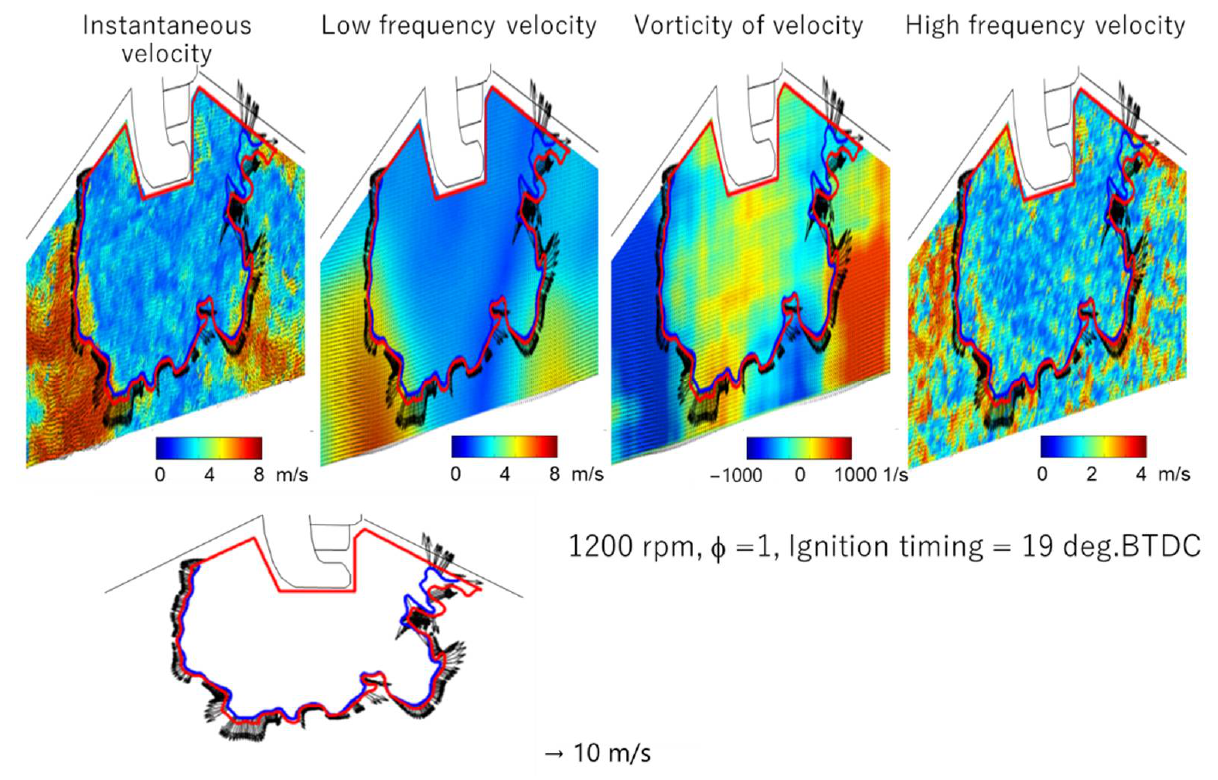
Figure 9. Interaction of flame front and bulk flow with turbulence component as well as vorticity.